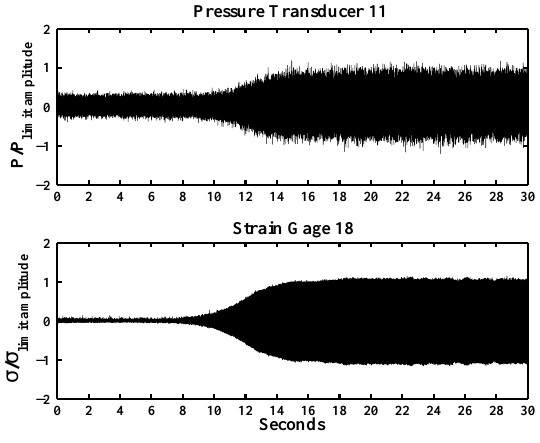
Fig. 4. Time dependent pressure and strain gage response for the fan as it is back-pressured into flutter.